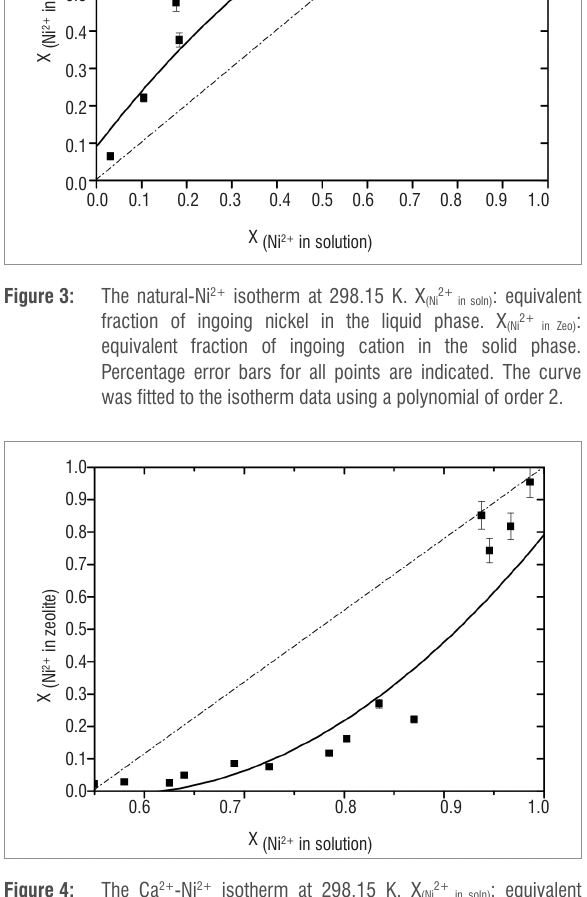
Figure 4: The Ca 2+ -Ni 2+ isotherm at 298.15 K. X (Ni2+ in soln) : equivalent fraction of ingoing nickel in the liquid phase. X (Ni2+ in Zeo) : equivalent fraction of ingoing cation in the solid phase. Percentage error bars for some points are indicated. The curve was fitted to the isotherm data using a polynomial of order